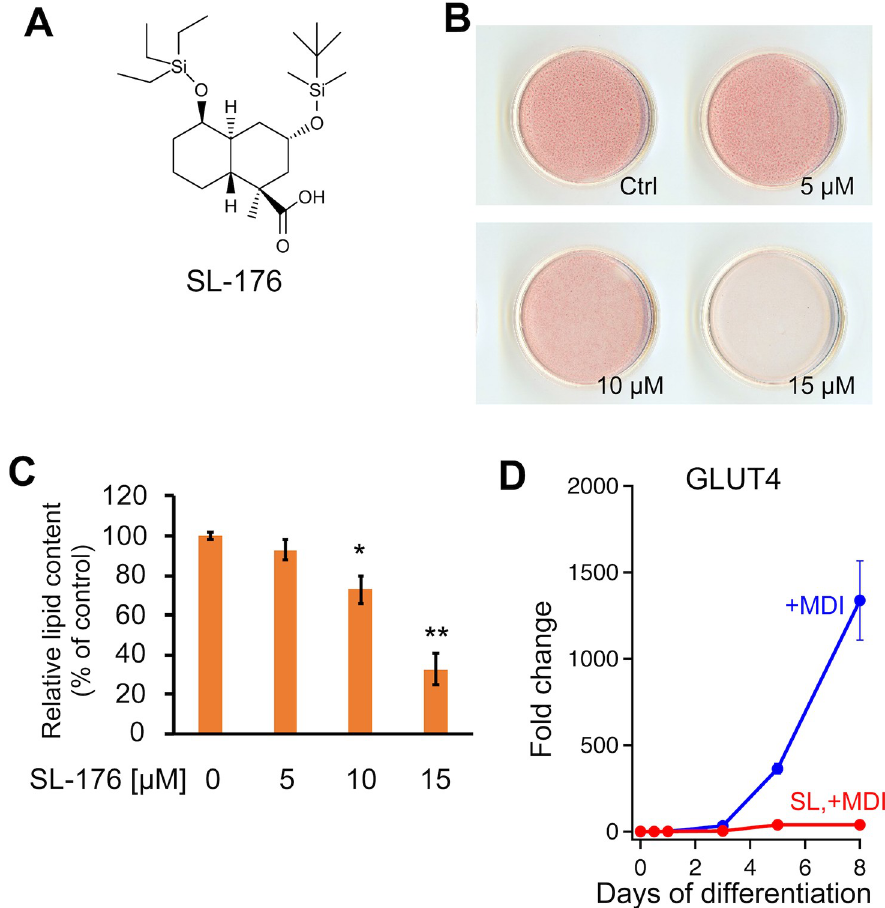
Fig 1. PPM1D inhibitor SL-176 suppresses cellular lipid droplet accumulation and adipocyte differentiation. (A) PPM1D inhibitor SL-176. (B, C) Quantification of lipid droplets in 3T3-L1 cells treated with the indicated concentrations of SL-176. Differentiated 3T3-L1 cells on Day 8 were stained with Oil Red O. (C) Absorbance of Oil Red O extract was measured at 490 nm. Data are mean ± S.D. values and obtained by three independent samples in each conditions ( � P < 0.05 �� P < 0.01 respectively, paired Student’s t-test) (D) mRNA expression of the adipocyte marker by RT-qPCR. Cells were treated with differentiation medium (MDI) with or without 10 μ M of SL-176. Blue, with MDI; red, 10 μ M of SL-176 with MDI. The data were normalized by actin and expressed as fold change. Values are the mean ± range of duplicates. Representative data from one of at least three independent experiments are shown. percentage of lipid droplets with diameters > 4 μ m in SL-176-treated cells was significantly decreased to only 1.6%, whereas the percentage in control cells was 21.3%. Moreover, the frac- tion of lipid droplets smaller than 2 μ m was 36% in control cells, and it became 73.6% after SL- 176 treatment. SL-104 did not affect lipid droplet sizes in 3T3-L1 cells (S2 Fig). This indicates that PPM1D inhibition significantly decreased lipid droplet size. Large lipid droplets were more slowly degraded than small lipid droplets[17]. Moreover, enlargement of lipid droplet causes hypertrophy of adipocyte and obesity. Therefore, it is worthy to note that SL-176 reduced the size of lipid droplet in adipocyte cells. During adipocyte differentiation, PPAR γ , C/EBP α , and C/EBP β , adipogenic transcription factors, were induced to increase their expression levels. Quantitative analysis of mRNAs dur- ing differentiation of 3T3-L1 cells in the presence of SL-176 indicated that PPAR γ and C/ EBP α were remarkably reduced by half or less than half in compared with control (Fig 4A).